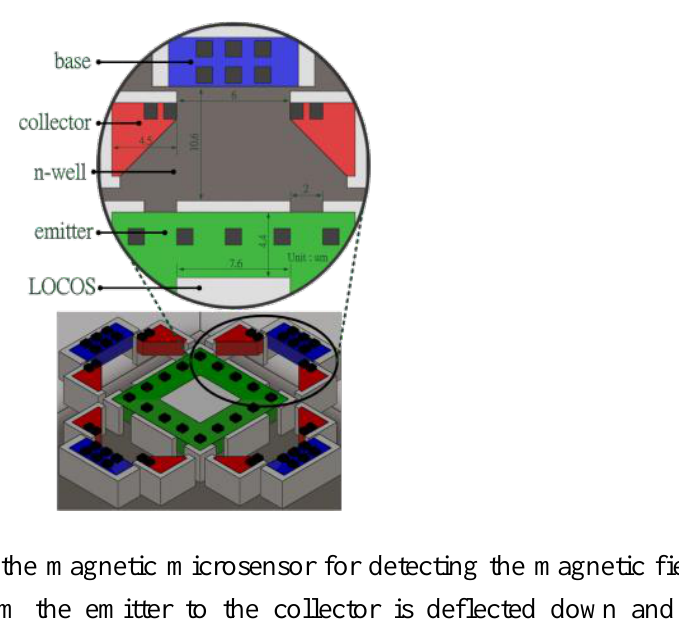
Figure 2. Isometric view of the magneto-transistor.